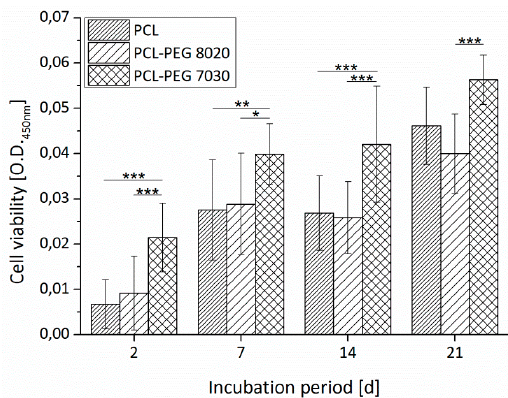
Figure 5. Cell viability of PCL and PCL-PEG plates seeded with ST2 cells over an incubation period of 21 days. Asterisks denote significant difference of pairwise comparison * p < 0.05; ** p < 0.01; *** p < 0.001.